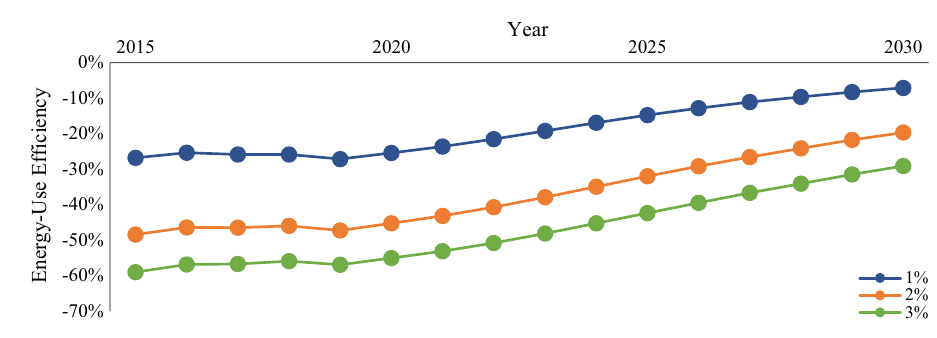
Fig. 2 The ITC impact on the energy-use efficiency